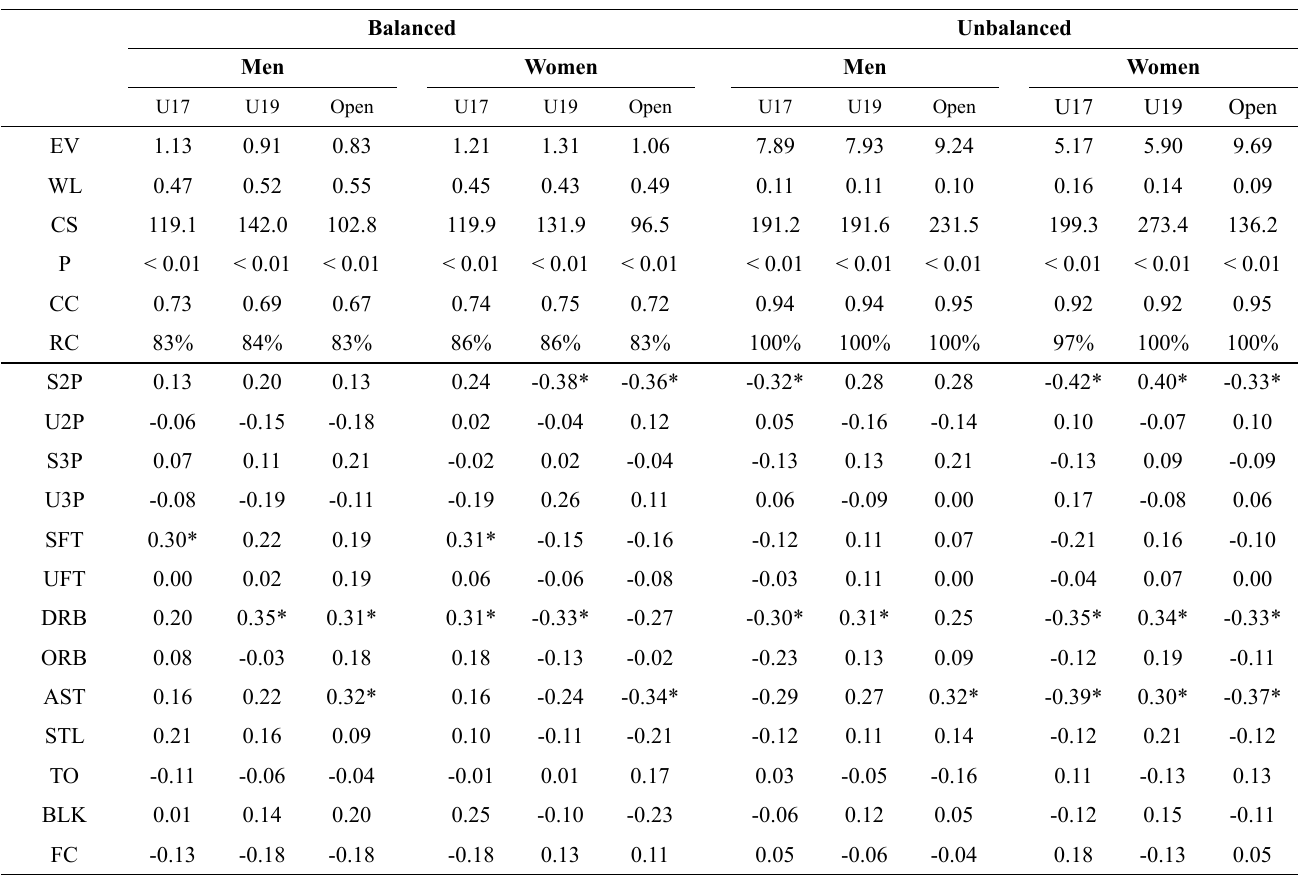
Table 4. Results of discriminant analysis with structural coefficients (SC) of game-related